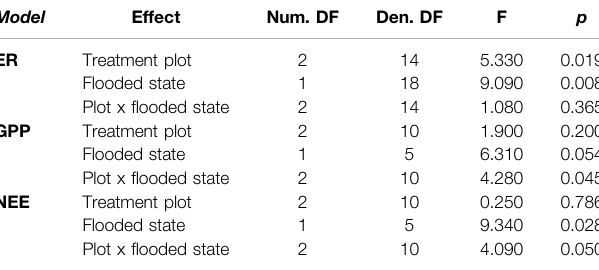
TABLE 1 | Results of mixed effects models testing the effects of experimental water table treatment, fl ooding, and their interaction on ecosystem respiration